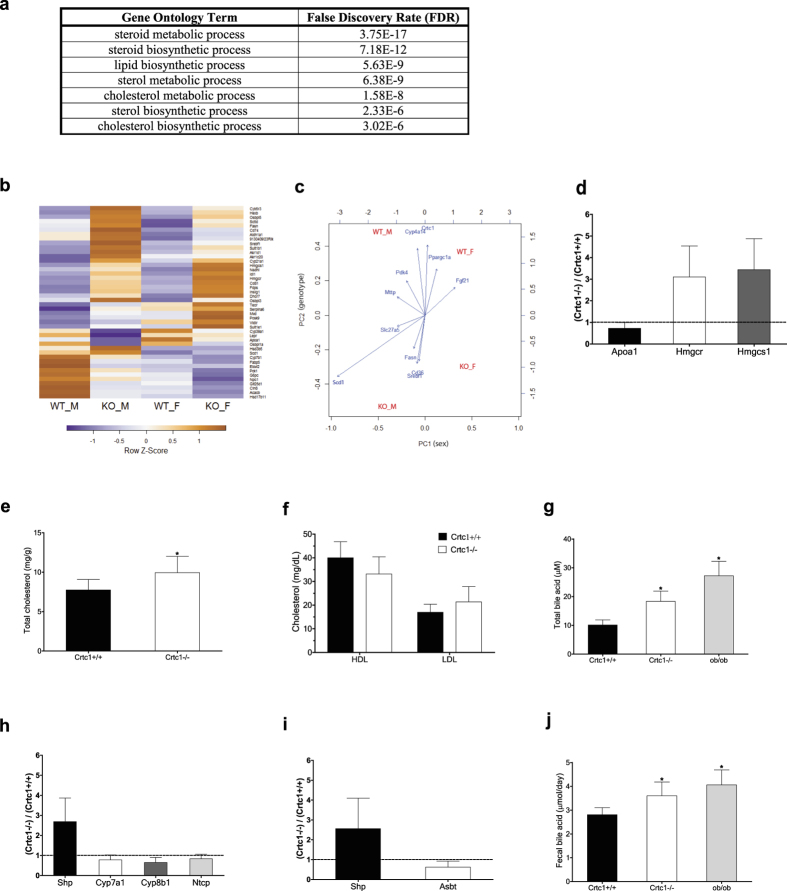
Crtc1 deficiency deteriorates lipid, cholesterol and bile acid homeostasis.(a–j) livers (a–e,h), serum (f,g), ileum (i), and feces (j) from 17 weeks old Crtc1-null (KO) and their wild-type (WT) littermates were compared. Unless otherwise specified, results for male mice were shown. (a–c) RNA-Seq analyses. M: male and F: female. Hepatic RNAs were pooled from 3 mice per sample. (a) Gene Ontology (GO) enrichment analysis of differentially expressed genes between Crtc1 KO and WT livers. (b) Heatmap of differentially expressed genes between KO and WT. Only those identified by the GO analysis (a) were shown. (c) Principal component analysis (PCA) and gene contribution plot. Principal component one (PC1) and two (PC2) primarily capture sex and genotype differences, respectively. Red: each sample in the PC space. Blue: contribution of each gene to the PCs. Downward (or upward) arrow indicates increased (or decreased) gene expression in Crtc1 KO mice. (d) Hepatic expression of genes involved in cholesterol homeostasis (RT-PCR). Expressions by Crtc1 KO liver are presented relative to expressions by wild-type liver (n > 7). All: p < 0.05 by paired sample t-test. (e) Total hepatic cholesterol. (f) Serum HDL and LDL cholesterol. (g) Serum total bile acid. (h) Hepatic expression of genes involved in bile acid homeostasis, presented as in d (all: p < 0.05). (i) Ileal expression of genes involved in bile acid homeostasis, presented as in d (all: p < 0.05). (j) Daily fecal bile acid excretion rate.